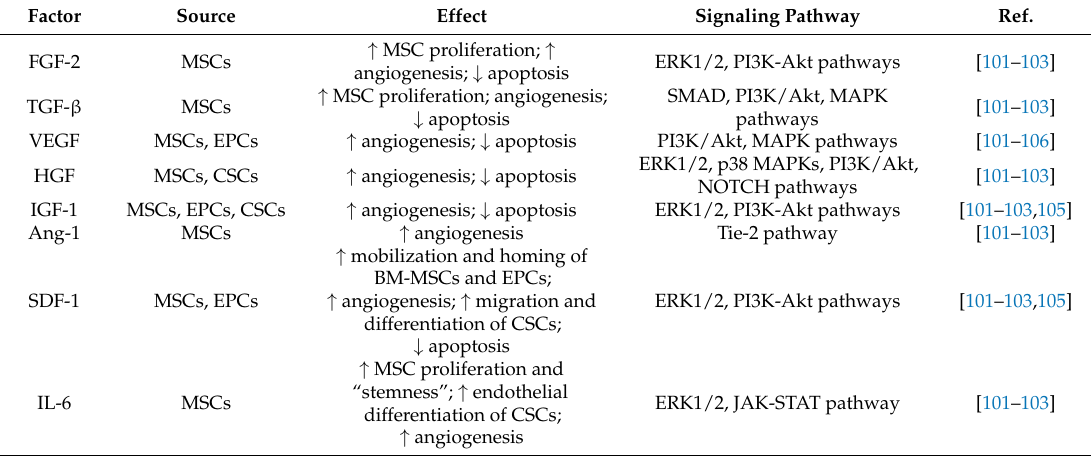
Table 4. Effects and signaling pathways of SC secreted factors mediating cardiac